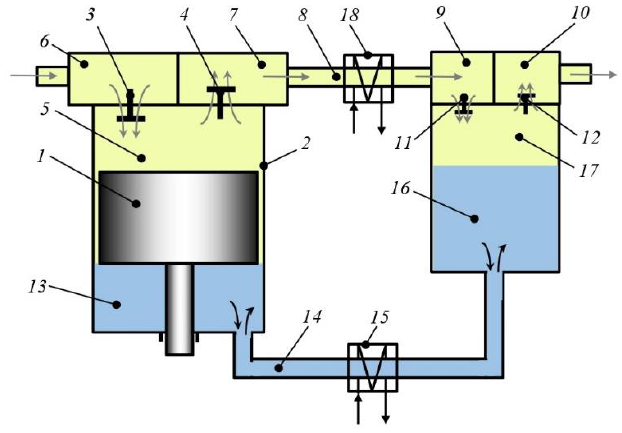
Figure 2. Schematic diagram of a two-stage PHPM without a cylinder cap.